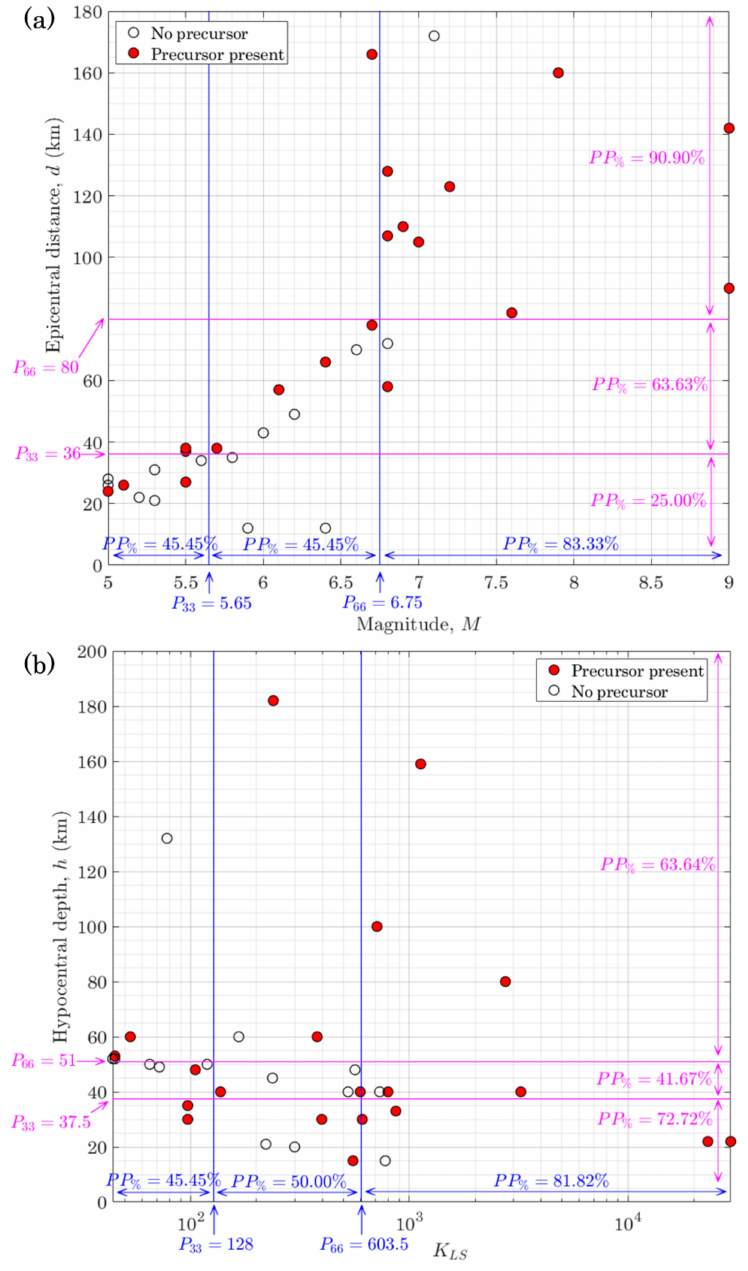
Figure 7. Distributions of precursor presences in terms of ( a ) epicentral distance, d against magnitude, M , and ( b ) hypocentral depth, h against K LS index. Earthquakes were divided into 3 groups based on their percentile ranks, i.e., P < 33 , P 33–66 and P > 66 . The percentage of precursor presences, PP % is shown for each